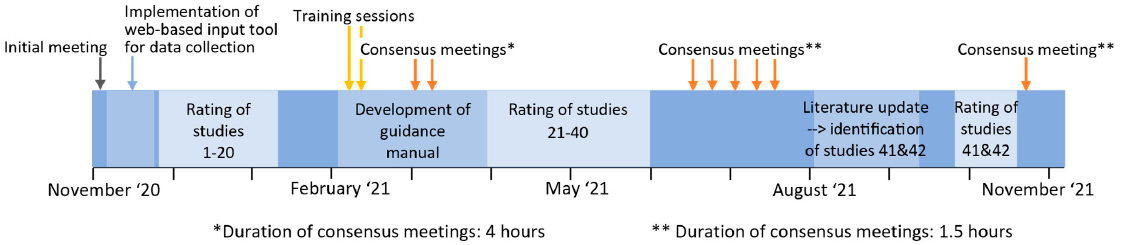
Figure 1. Timeline of the PROBAST assessment study from the initial meeting until the final consensus meeting showing all steps of the study.